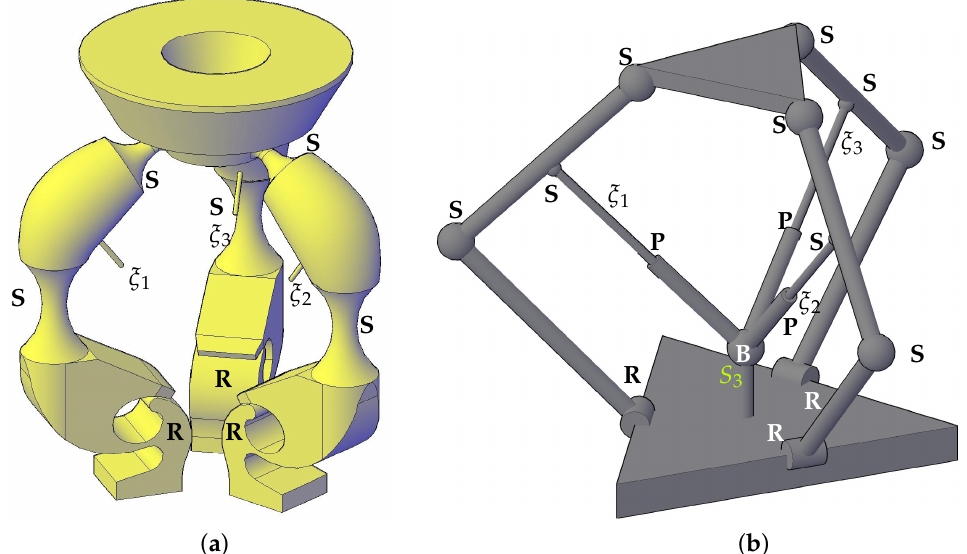
Figure 2. The compliant platform ( a ) and its corresponding pseudo-rigid body mechanism ( b ), with the equivalent revolute joints R, spherical joints S, prismatic pairs P, a triple spherical joint S 3 , and the cable directions ξ 1 , ξ 2 , and ξ 3